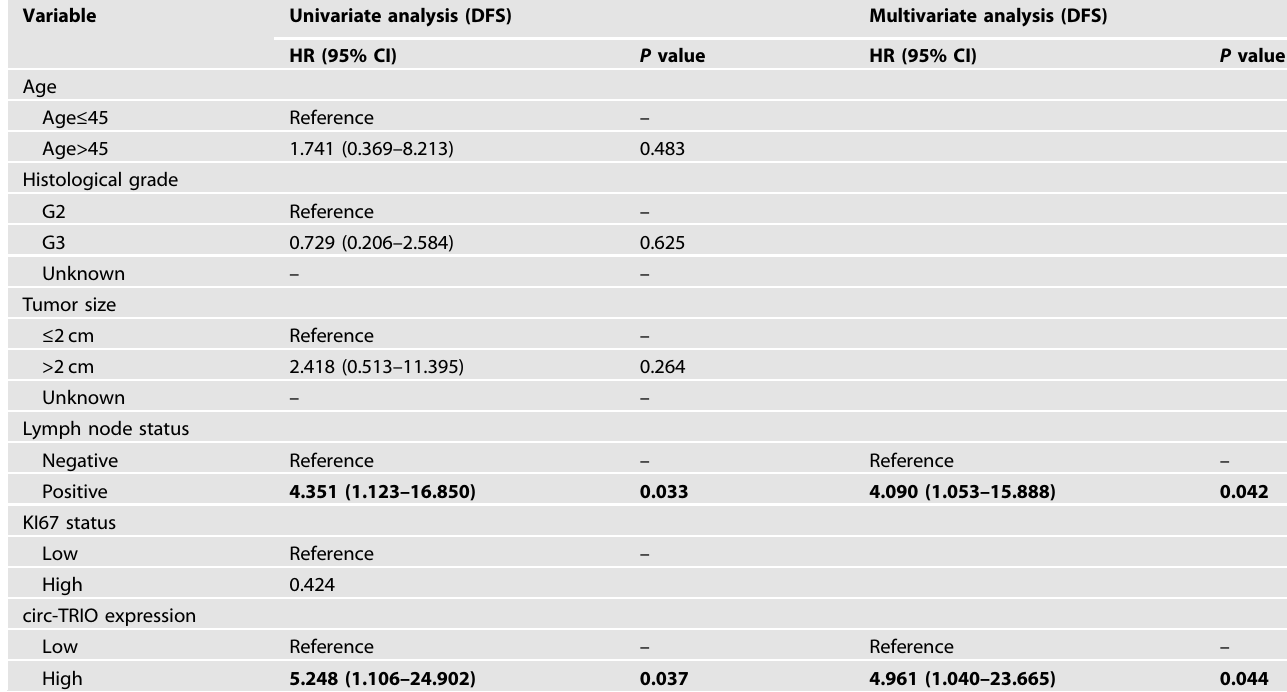
Table 2. Univariate and multivariate analyses of prognostic factors (DFS) for patients with TNBC. Variable